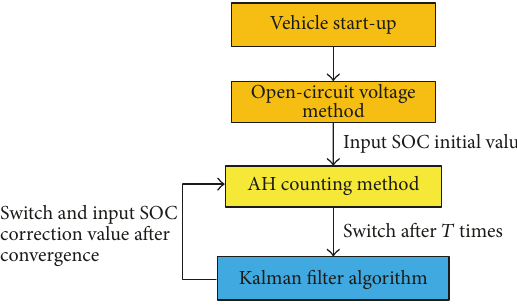
Figure 2: Time sequence of proposed SOC estimation strategy for single battery